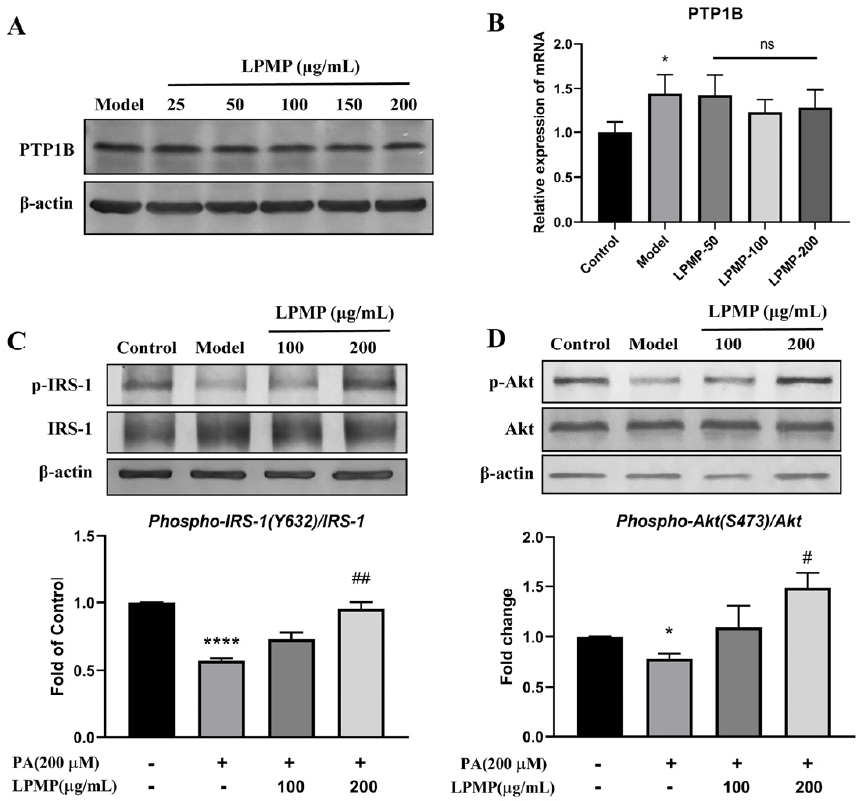
Figure 5. Effect of LPMP on the insulin signaling pathway. ( A ) Effect of LPMP on cellular PTP1B protein expression. ( B ) PTP1B mRNA level was measured by RT-PCR. After treatment with different concentrations of LPMP, cells were then continued to be treated with 100 nM insulin in serum-free MEM for 10 min. Phosphorylation levels of IRS-1 ( C ) and Akt ( D ) were detected by immunoblotting. The band density was quantified and β -actin was used as a standard. The results shown are means ± SEM ( n = 3). * p < 0.05, **** p < 0.0001 versus control group; # p < 0.05, ## p < 0.01 versus model group. Meanwhile, insulin signaling is initiated when insulin binds to the extracellular α - subunit of the insulin receptor, and downstream phosphorylation of IRS-1 at key tyrosine residues is critical for signal transduction [46,47]. PTP1B plays a negative regulatory role in insulin signaling through dephosphorylation of IRS-1 tyrosine. Therefore, we explored the effect of LPMP on the insulin signaling pathway. After inducing insulin resistance in HepG2 cells by PA, cells were stimulated with 100 nM of insulin for 10 min after 24 h of LPMP treatment. The expression of phosphorylated IRS-1 (Y632) and AKT (S437) was significantly upregulated compared to the PA-treated group (Figure 5C,D). Our results confirmed that LPMP could activate insulin sensitivity by upregulating insulin signaling through activation of the IRS-1/AKT signaling